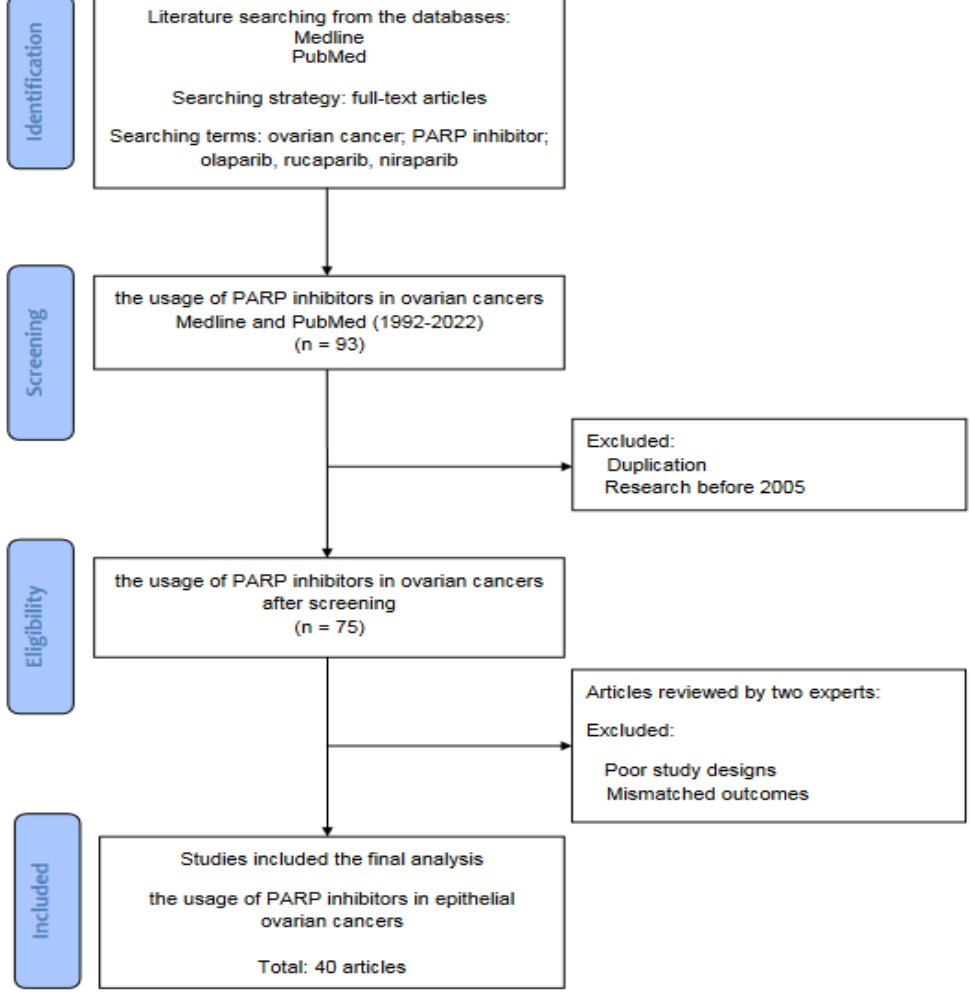
Figure 1. The flowchart of database searching, screening, selection, and inclusion of eligible articles from the literature.